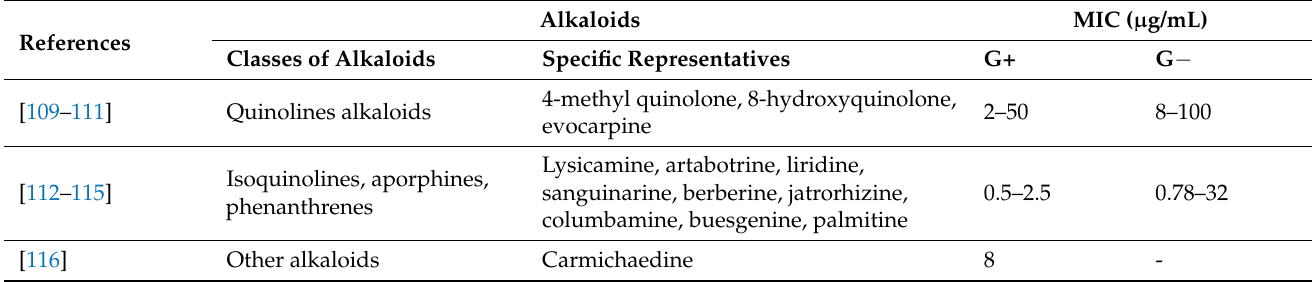
Table 3. The minimum inhibitory concentrations of selected alkaloids against gram-positive and gram-negative